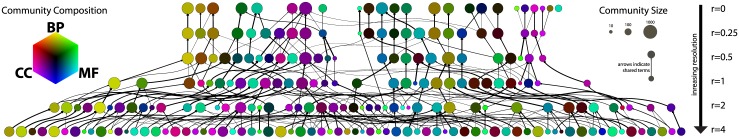
Visualization of Communities (Circles) of GO Terms Found at the Six Lowest Levels of Resolution (Rows), in Increasing Order (Top to Bottom).The width of the line connecting two communities is proportional to the percentage of terms in the child community that are also in the parent community. The size of communities is proportional to the log of the number of terms in the community. Color represents the normalized percentage of terms in the community which belong to the BP (yellow), MF (cyan) and CC (magenta) primary domains.